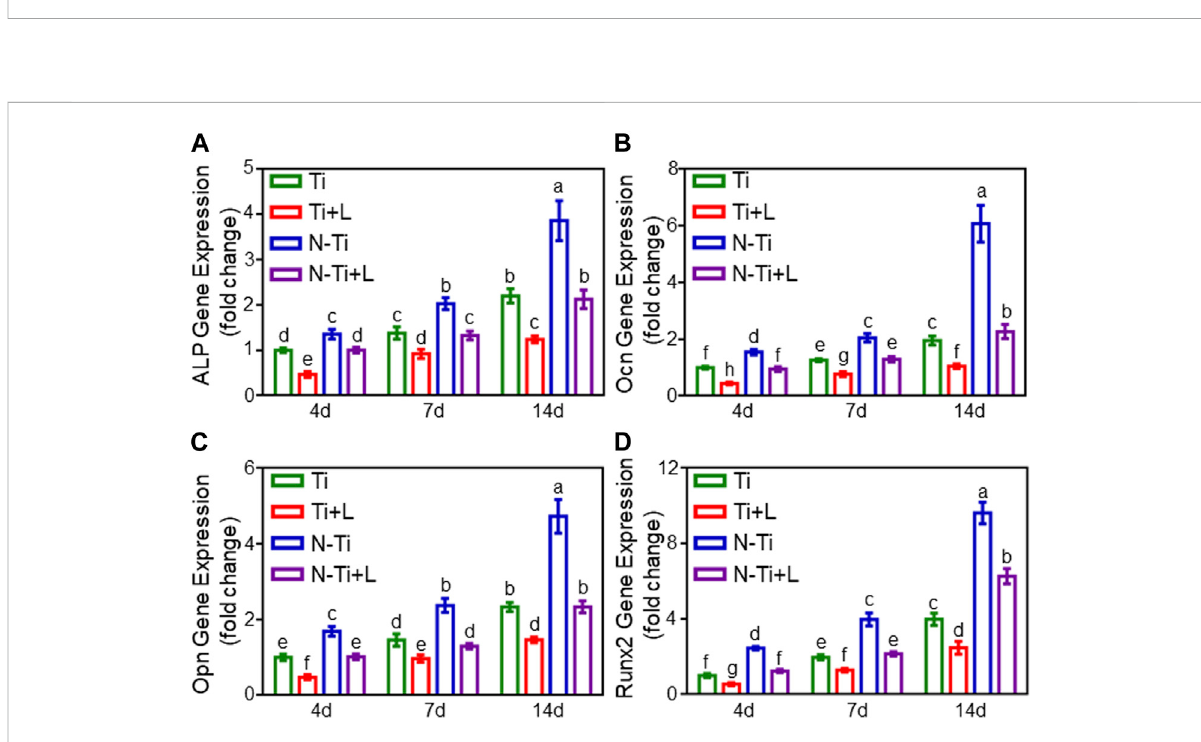
FIGURE 3 The expression of osteogenic-relatedgenes ofMC3T3-E1 cells on Ti, Ti + L, N-Ti, N-Ti + L surfaces for 4, 7, and 14 d: (A) ALP, (B) Ocn, (C) Opn, (D) Runx2. Results are shown as mean ± SD; n = 6/group. Values with diverse letters are notably different ( p < 0.05).